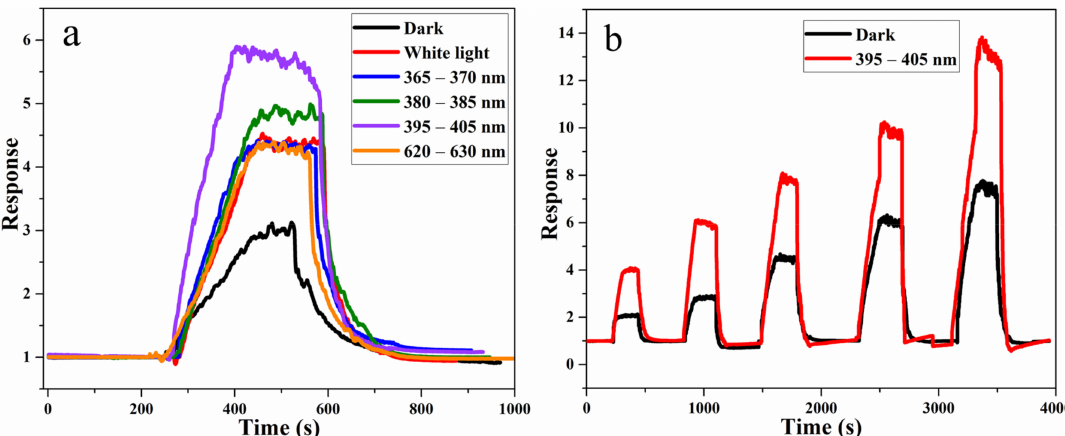
Figure 7. ( a ) Test of gas sensitivity of TiO 2 − CoFe 2 O 4 − Ag to toluene at 263 ◦ C in darkness and under the light of different wavelengths, and ( b ) dynamic response curve of TiO 2 − CoFe 2 O 4 − Ag to toluene gas in darkness and under UV